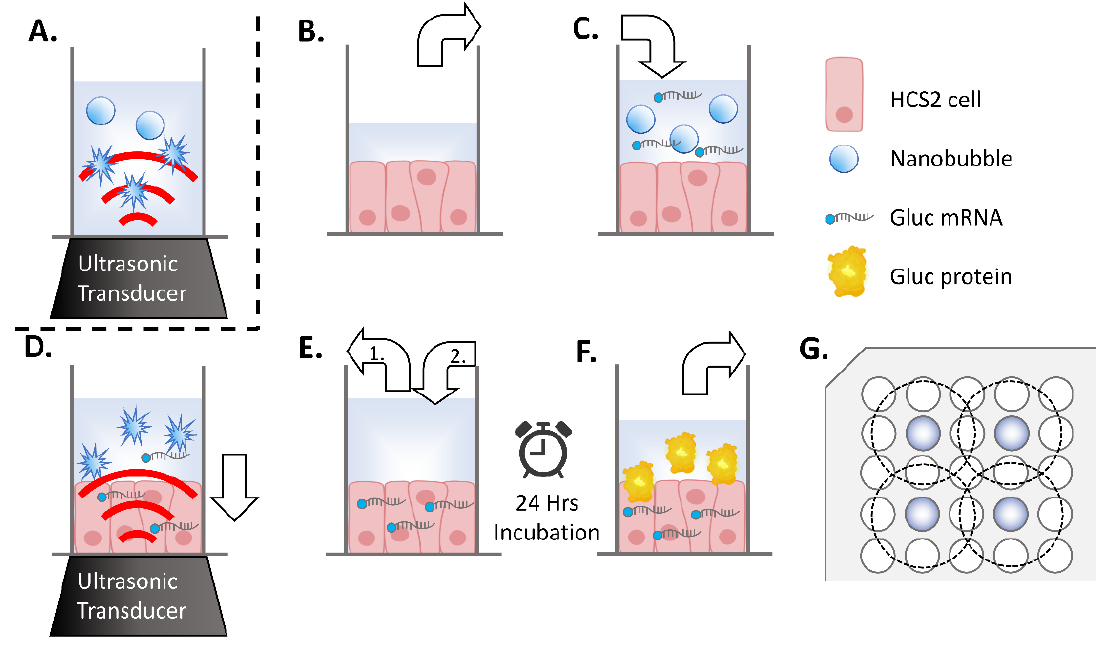
Figure 1. Schematic representation of sonication treatment of nanobubbles (NBs) or sonoporation in 96-well plates. ( A ) Sonication treatment of NBs by ultrasonic irradiation to medium. ( B – F ) Method of sonoporation. ( B ) The incubation medium is removed from the well (white arrow) of a 96 multi-well plate seeded with human squamous carcinoma (HSC-2) cells. ( C ) Each well is filled with medium containing NBs (white arrow). ( D ) Transfection by ultrasonic irradiation. mRNA is transferred into the cytoplasm (white arrow). ( E -1) Aspiration of sonicated medium and ( E -2) addition of new incubation medium. ( F ) After a 24 h incubation period, the supernatant was collected for a reporter assay. ( G ) Arrangement of wells of seeded cells (indicated with color) and ultrasonic irradiation area (inside of dashed circle) on a 96 multi-well plate.